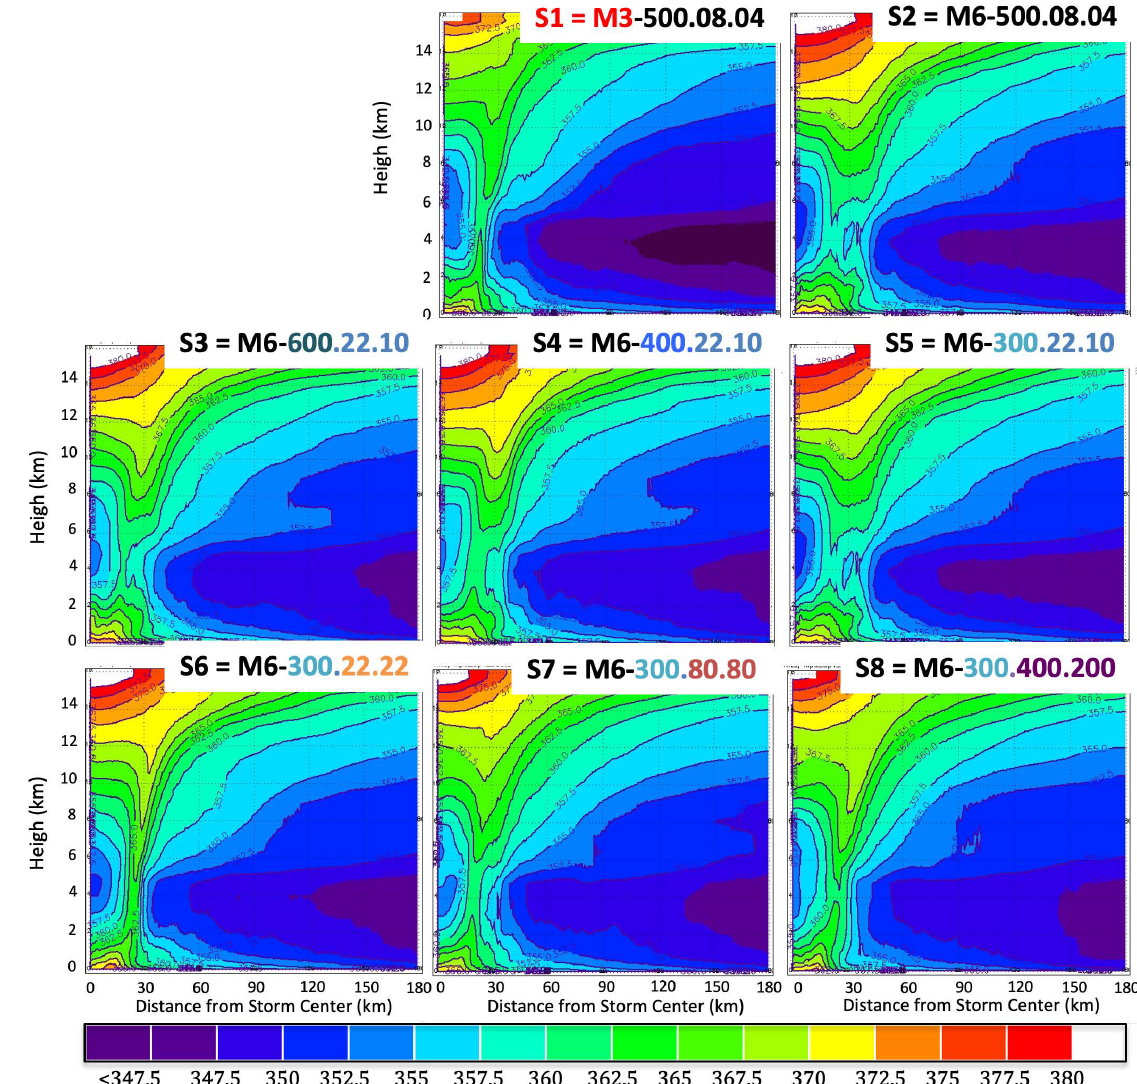
Figure 4. As in Figure 3, except shown is the azimuthal average of equivalent potential temperature θ e